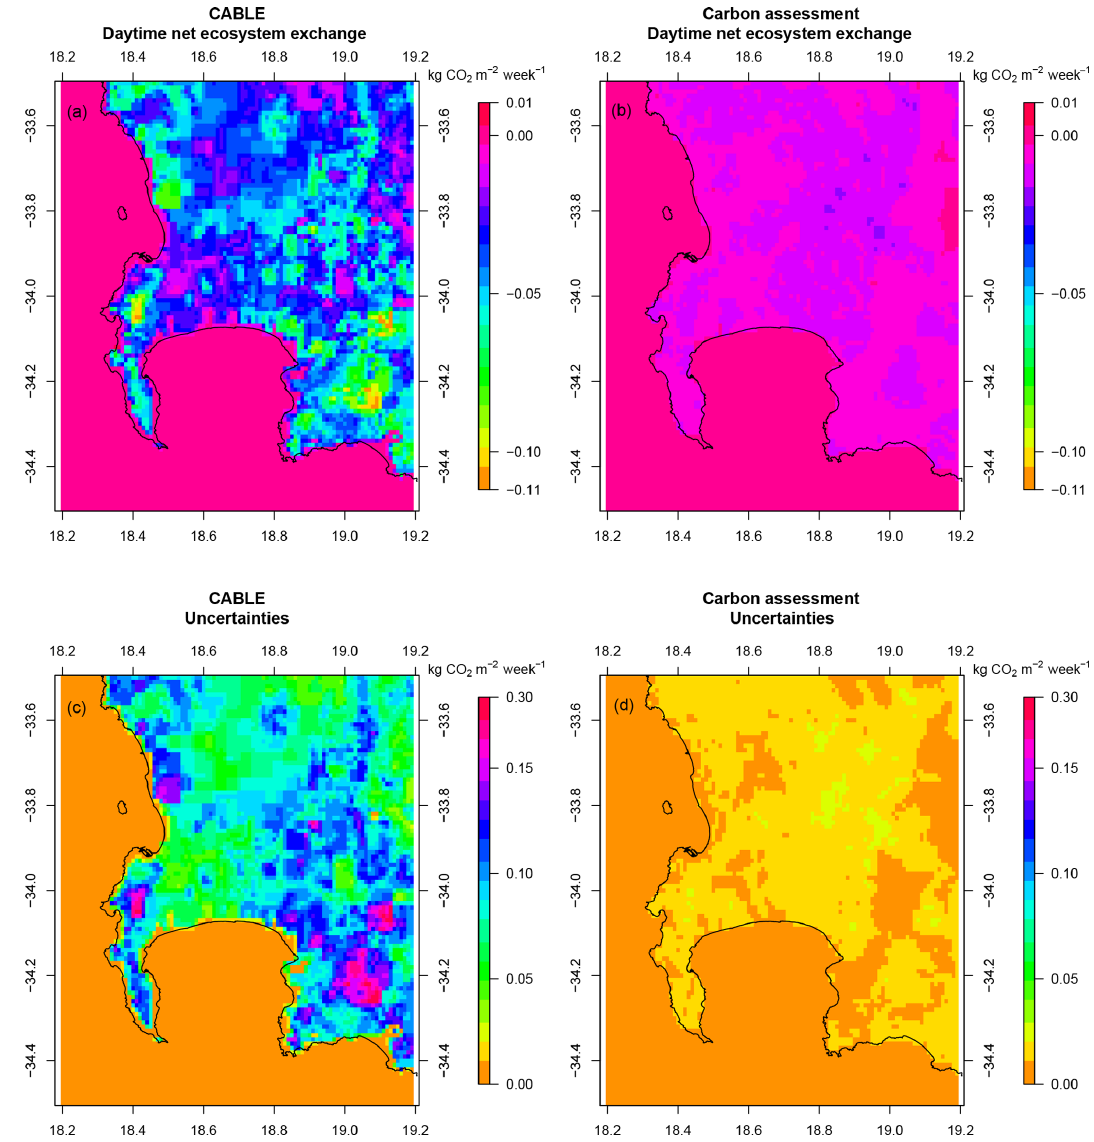
Figure 1. Spatial distribution of the prior daytime NEE fluxes produced by CABLE (a) and the carbon assessment product (b) for May 2012, as well as the uncertainty estimates assigned to these fluxes (c, d) . The scale for the prior NEE estimates is set between − 2 week − 1 , whereas the scale for the uncertainties, determined from NPP estimates, ranges between 0.00 and − 0 . 11 and 0.01kgCO 2 m 0.30kgCO 2 m − 2 week − 1